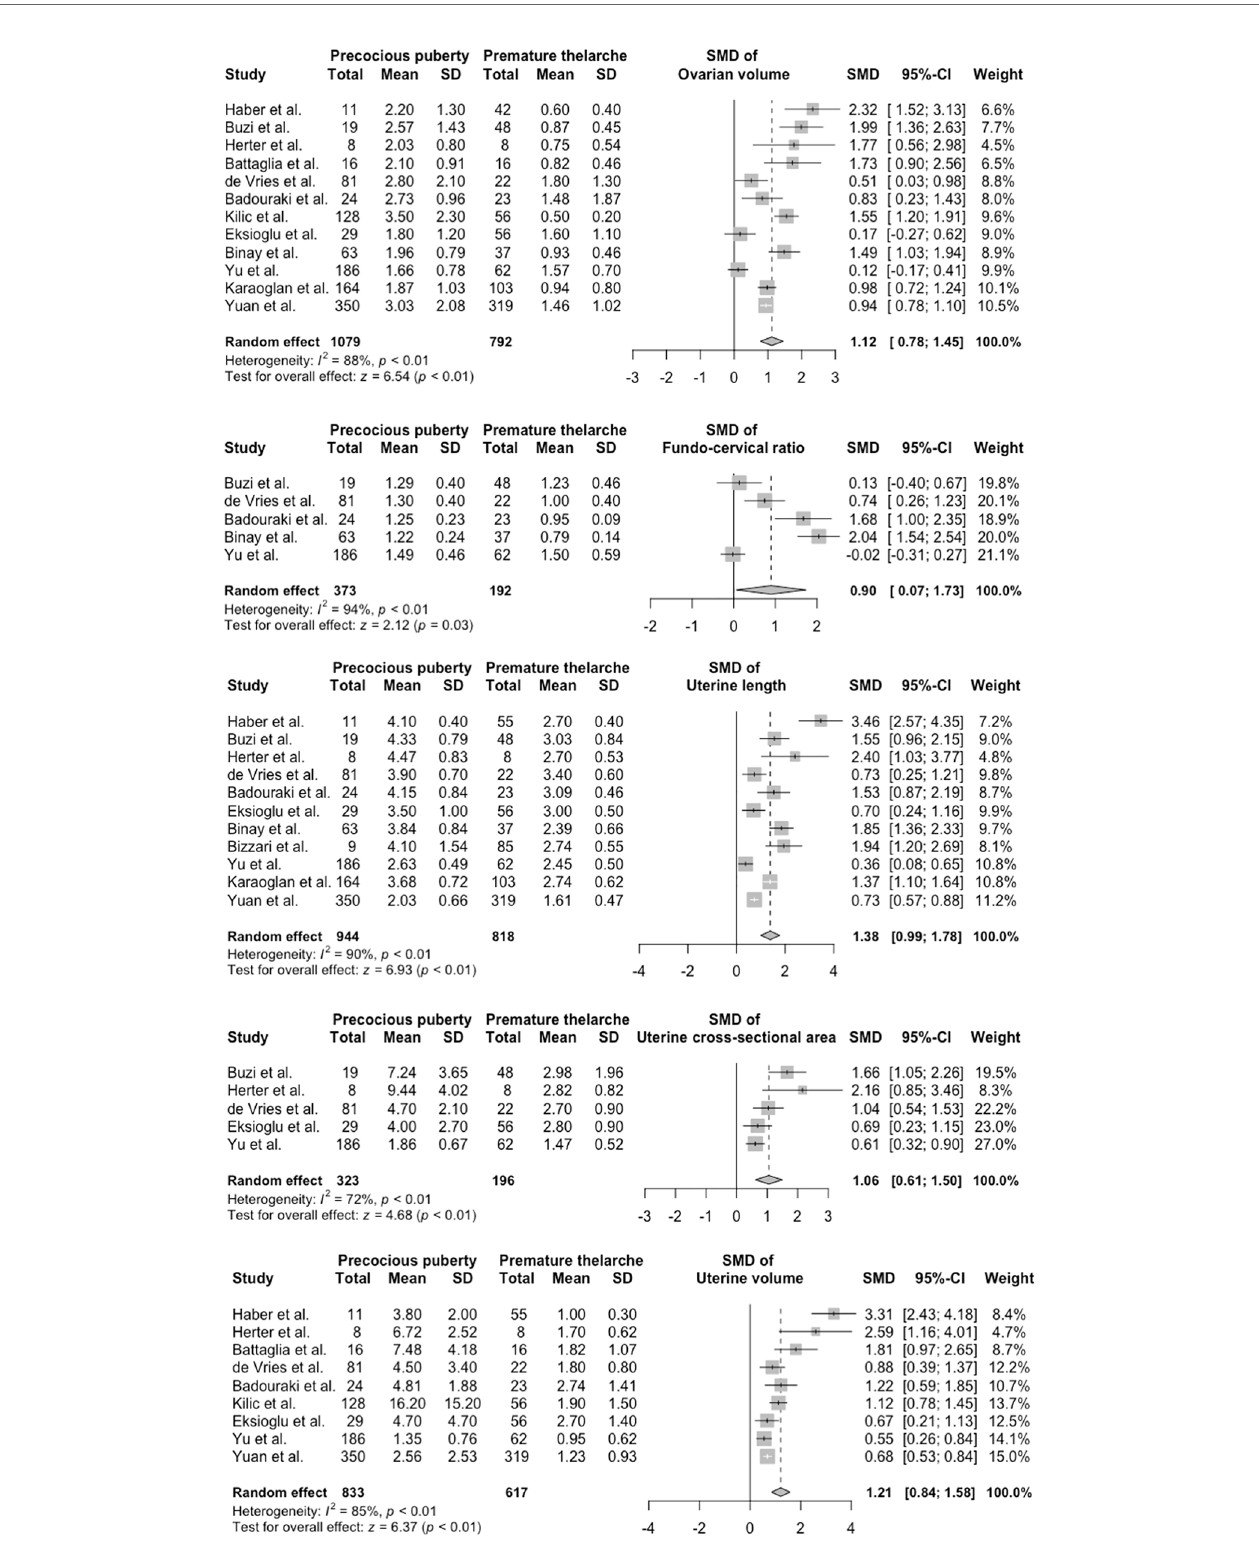
FIGURE 2 | Forest plots of standardized mean difference in ultrasonography parameters between PP and PT groups. PP, precocious puberty; PT, premature thelarche; SD, standard deviation; SMD, standardized mean